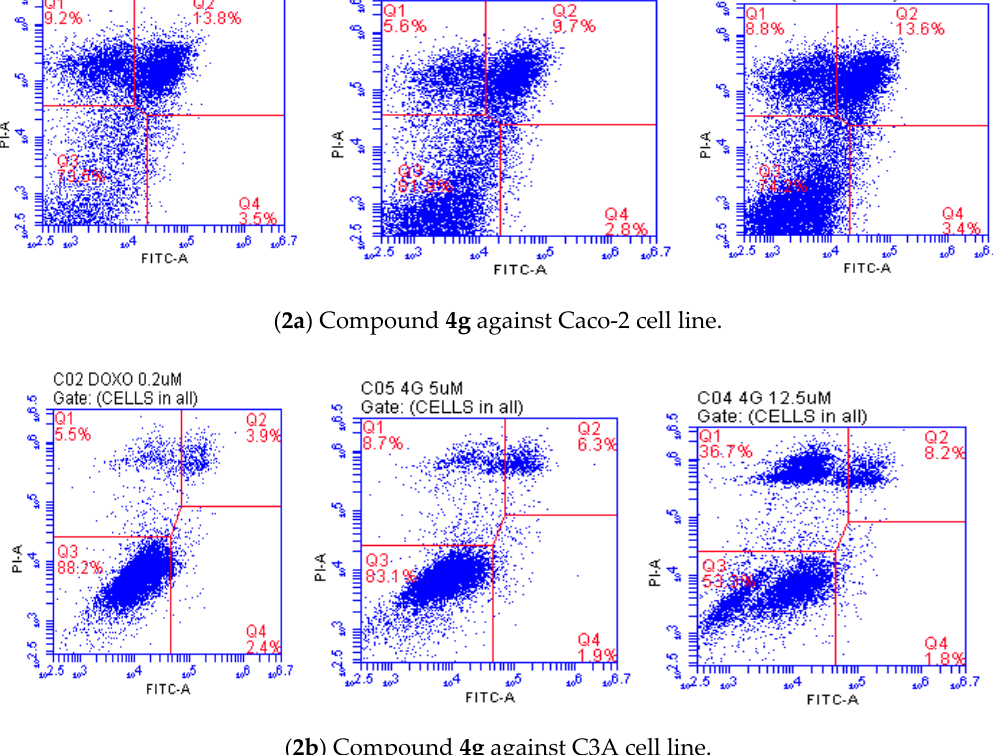
Figure 2. Effects of compound 4g on the induction of apoptosis in the Caco-2 (2a) and C3A cells (2b) at 5 and 12.5 μ M after 24 h against doxorubicin hydrochloride as determined by Annexin V/PI staining.